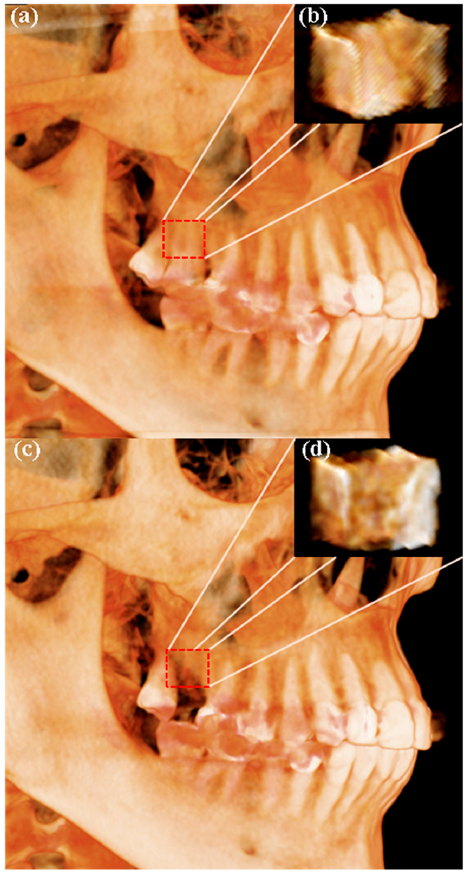
Figure 4. Volumetric analysis of hard tissue. The three-dimensional cone beam computed tomography (CBCT) images were taken at baseline ( a ) and at 4 months after ridge preservation ( c ). The regions of the postextraction socket/ridge preservation sites were determined. The cropped preoperative hard tissue ( b ) and postoperative hard tissue ( d ) volumes were measured in cubic mm (mm 3 ) via InVivoDental software, Version 5.0 (Anatomage Inc., San Jose, CA, USA).